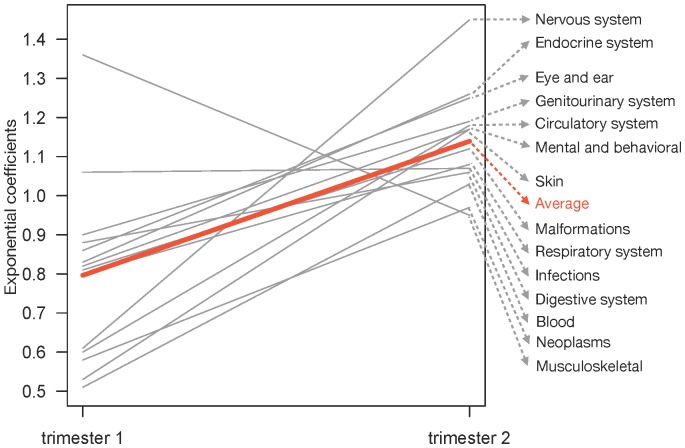
Interaction plot of the risk (exponentiated risk coefficients) of being diagnosed within the first 27 years of life for offspring born to mothers with pregnancy-induced hypertension (PIH) in either trimester 1 (left) or trimester 2 (right).Coefficients <1 indicate decreased risk and >1 increased risk of being diagnosed with disease. Grey lines represent the 14 main disease groups and the red line is the overall average, which was significantly higher (P<0.001) for offspring born to mothers with PIH in trimester 2 compared to trimester 1. The plot is based on numbers from Table S1.